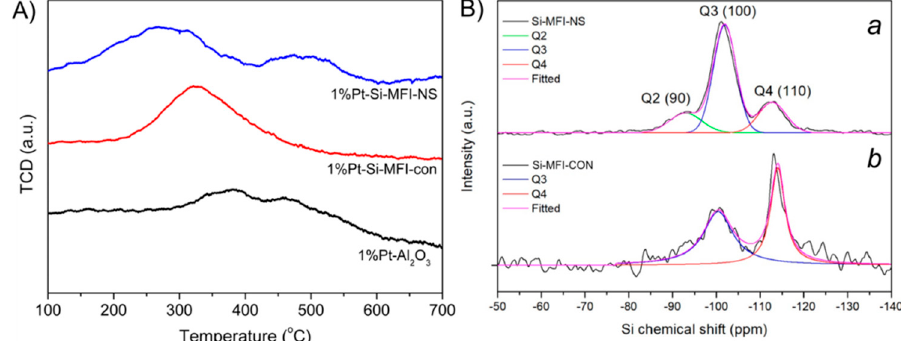
Figure 2. ( A ) H 2- TPR profiles of Pt supported on different supports, including hierarchical silicalite- 1 nanosheets (1% Pt-Si-MFI-NS) (blue), conventional silicalite- 1 (1% Pt-Si-MFI-CON) (red) and alumina (1% Pt-Al 2 O 3 ) (black), and ( B ) 29 Si NMR spectra of ( a ) hierarchical silicalite- 1 nanosheets (Si - MFI - NS) and ( b ) conventional silicalite - 1 (Si - MFI - CON).